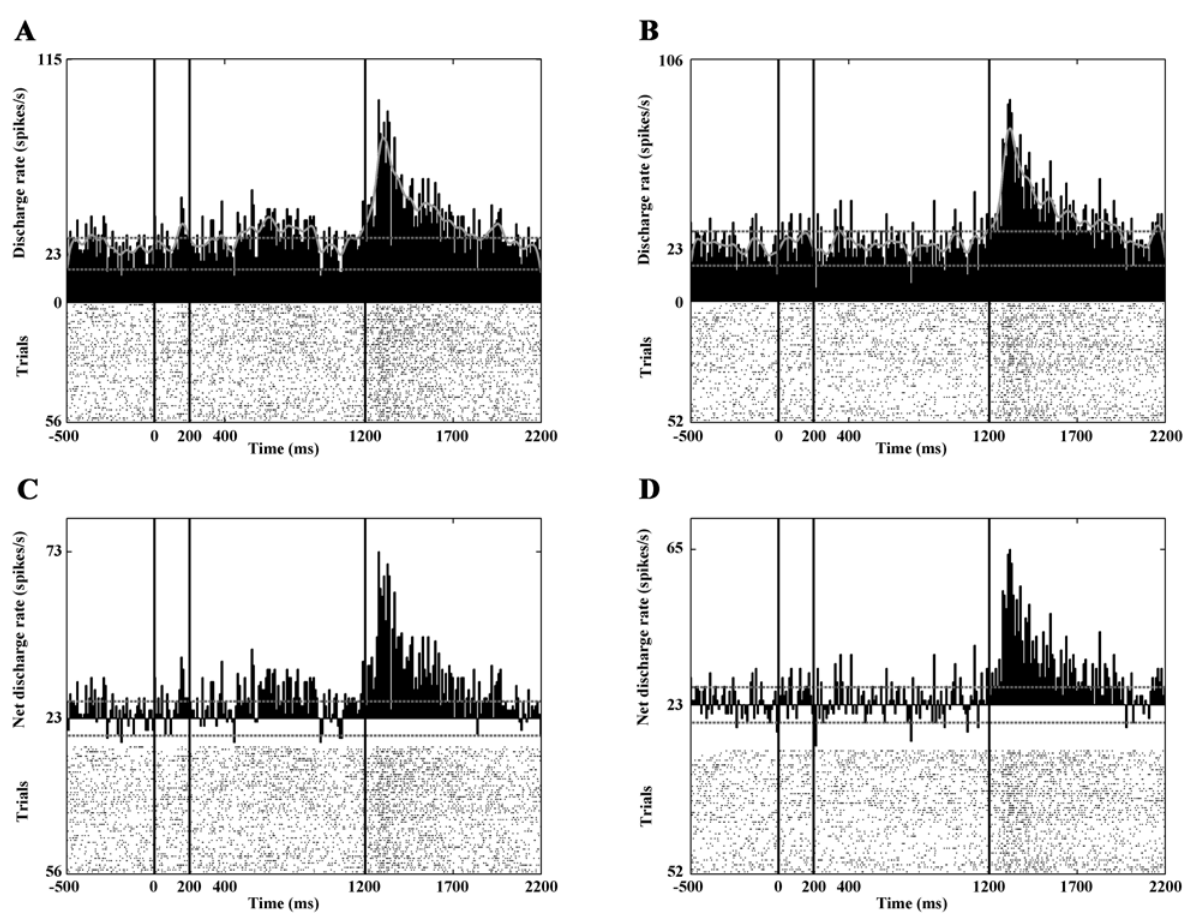
Fig 7. Selective responses to the direction of the optic flow. This figure demonstrates the activity of a HFN. Panels A (gross activity) and C (net activity) show the activities in response to center-out optic flow. Panels B (gross activity) and D (net activity) show the activities in response to center-in optic flow. Note that this neuron exhibits increased activity to center-out optic flow but no response to center-in optic flow. In other words, the neuron is selectively sensitive to the center-out direction. A strong reward-related activity can also be observed. The conventions are the same as in Fig